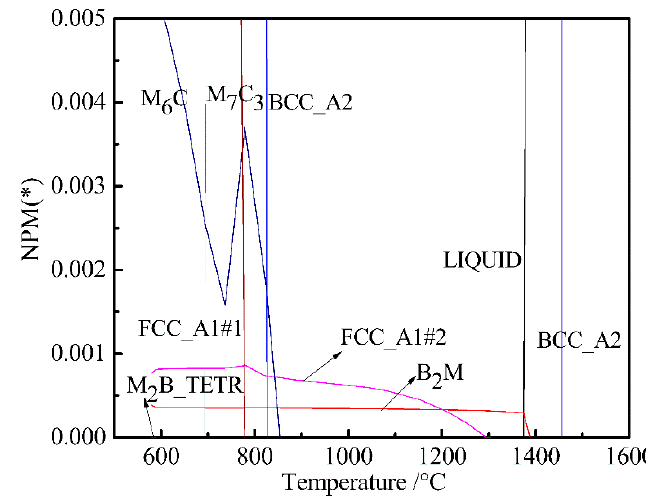
Figure 4. Partial magnification phase diagram of W-free bainite steel.